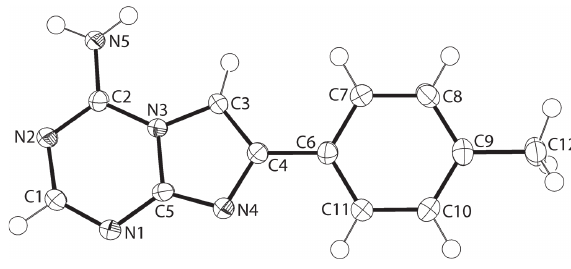
Table 1: Data collection and